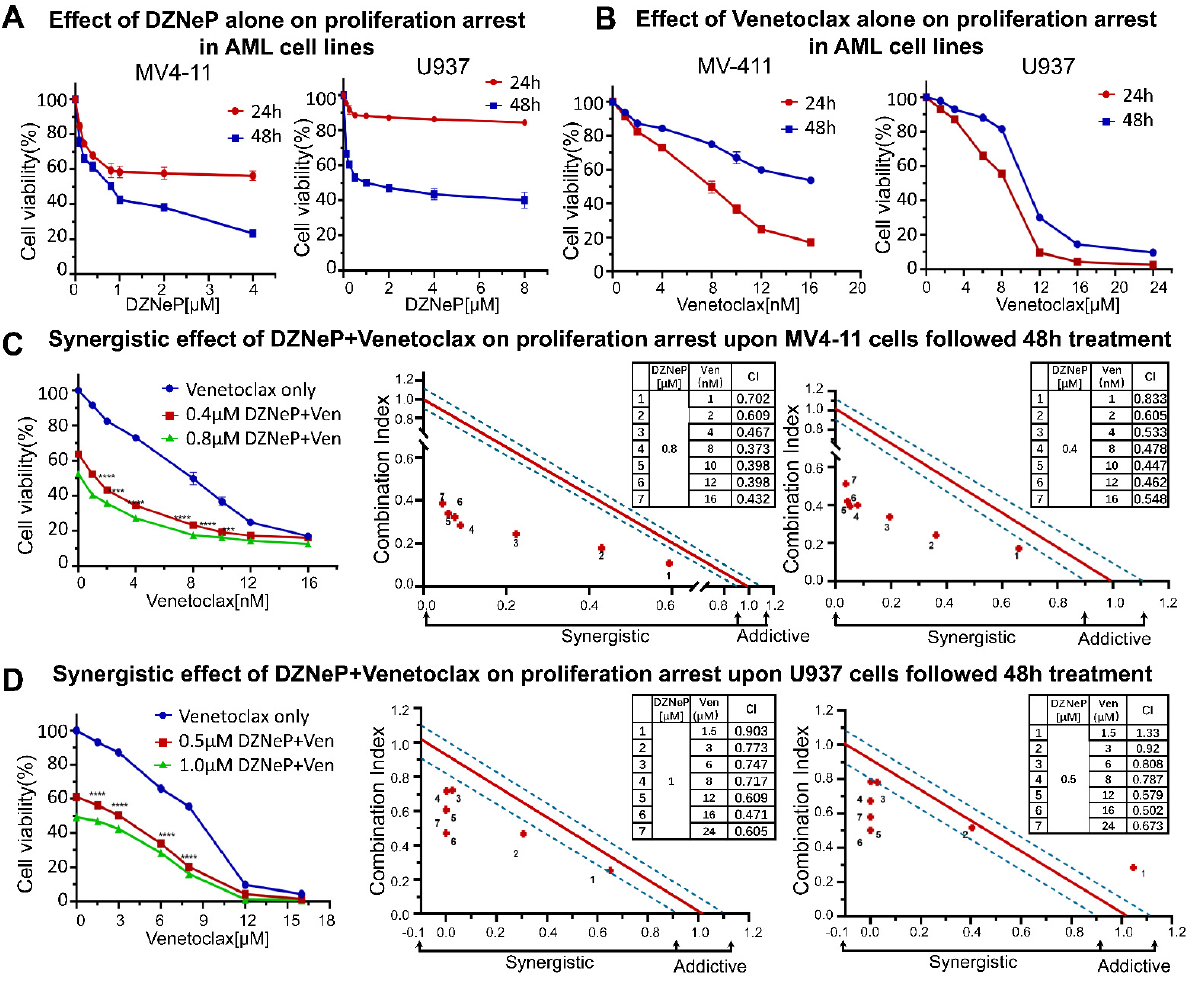
Figure 1. Synergistic effects of DZNeP with Ven on cell proliferation arrest in AML cell lines. ( A , B ) Effects of DZNeP or Ven alone on the proliferation of MV4-11 and U937 cells. Cells were treated with the indicated doses of drugs for 24 and 48 hrs. Cellular viability was measured by a CCK-8 assay. ( C , D ) Synergistic effects of Ven in combination with 0, ½IC50, or IC50 doses of DZNeP on the proliferation of MV4-11 and U937 cells. Synergistic analysis was performed with Calcusyn, where a combination index value of 1.1 to 0.9 is considered an additive effect, <0.9 is a synergistic effect, and >1.1 is an antagonistic effect, respectively. Mean ± SD of triplicates is representative of 1 of 3 independent experiments. ***, p<0.001. **** p <0.0001.